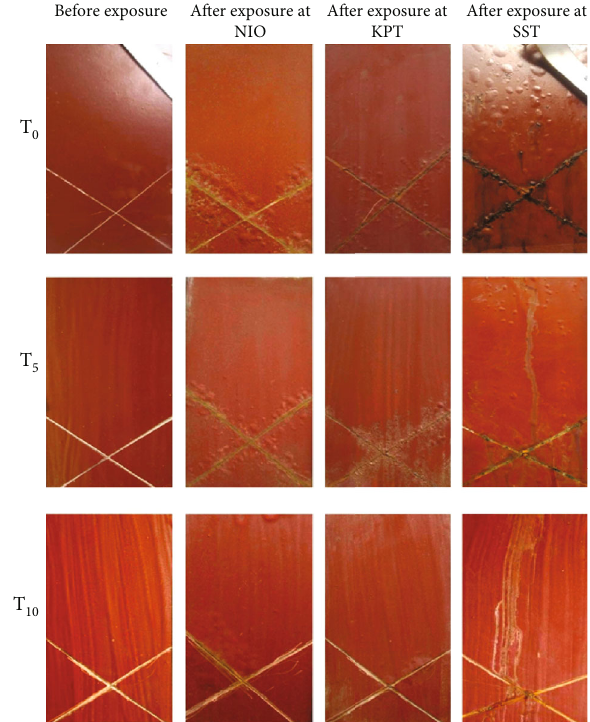
Figure 1: Visual appearance of the virgin epoxy coating (T the titanium-impregnated epoxy coatings (T natural exposure (NIO and KPT) and salt spray testing